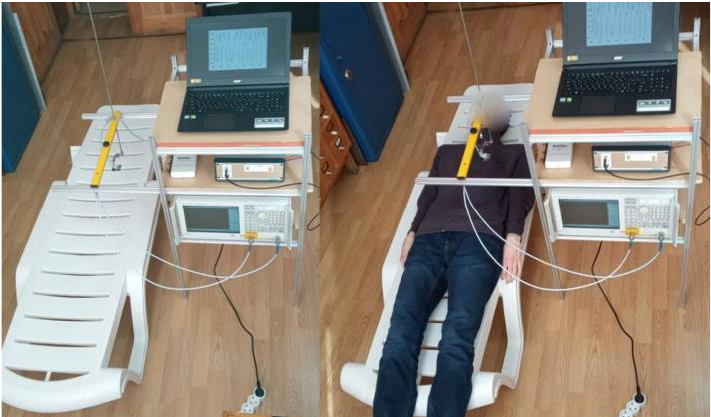
Figure 6. Experimental setup.